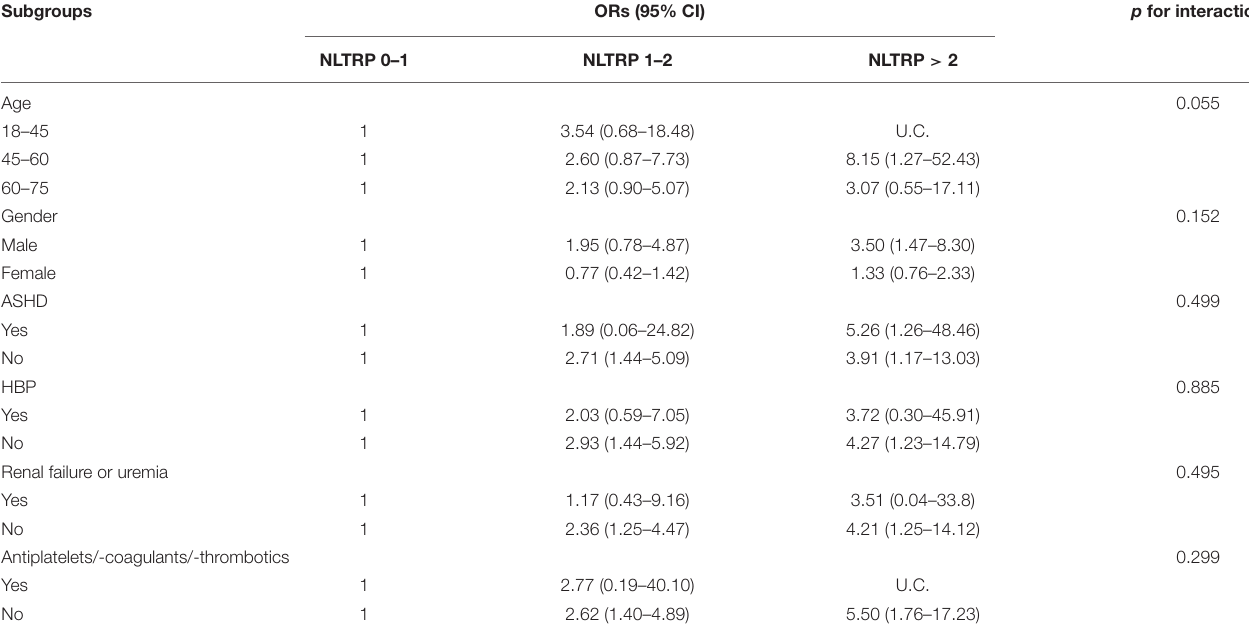
TABLE 3 | Subgroup analysis of the associations between NLTRP and deterioration of mTBI.